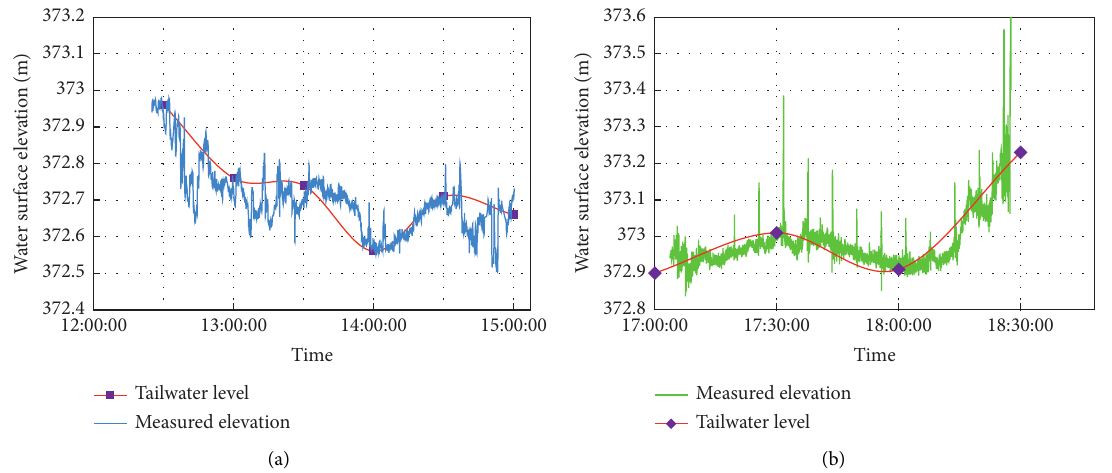
Figure 9: Diagram of water surface elevation variation. (a) Surface outlet stilling basin. (b) Bottom outlet stilling